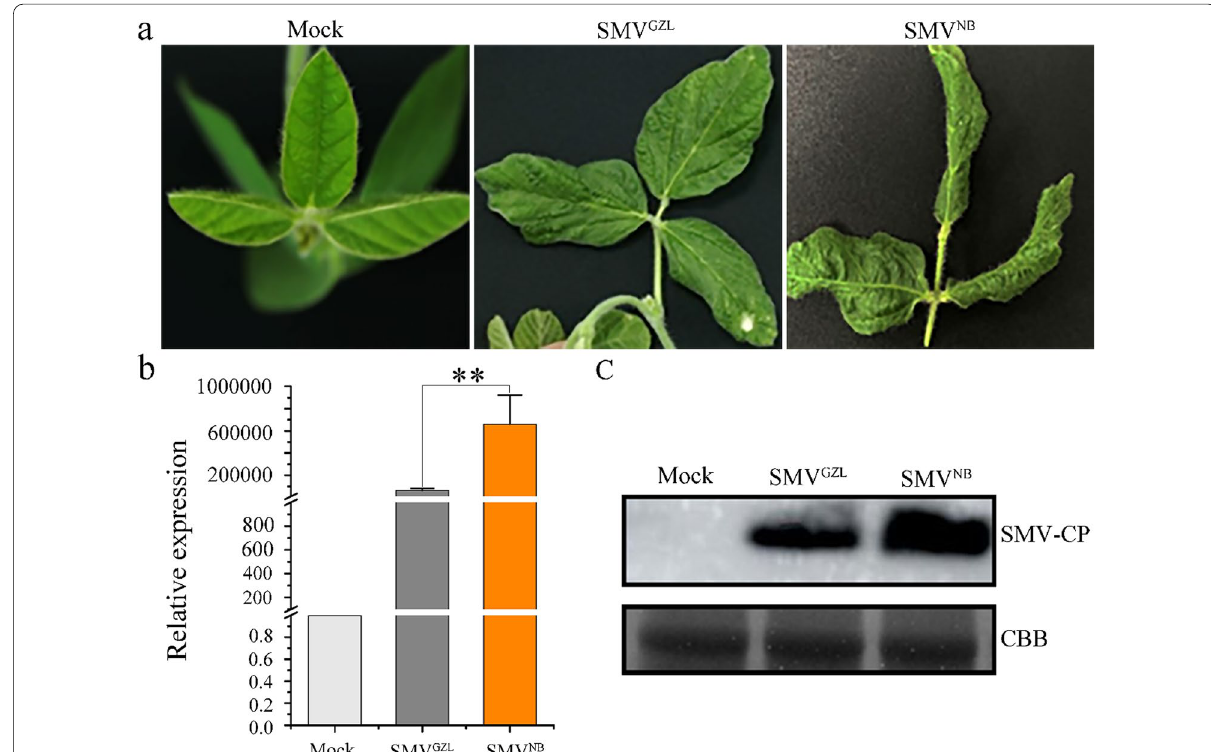
Fig. 1 Symptoms of SMV isolates SMV GZL and SMV NB infection on soybean. a Photographs of systemic (non-inoculated) leaves of Dongnong 51 plants at 30 dpi. b RNA levels of SMV NB and SMV GZL in infected plants determined by RT-qPCR. Data are shown as mean replicates. ** P < 0.01, Student’s t tests. c Immunoblots showing levels of SMV coat protein (CP) in plants mock-inoculated or inoculated with SMV NB / SMV GZL . Coomassie brilliant blue (CBB) staining of the same extracts shows equal